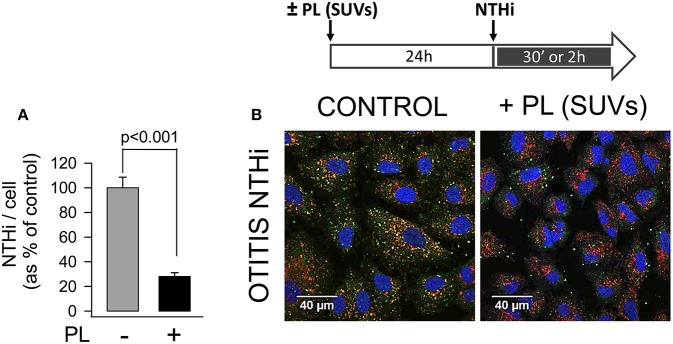
Endocytosis of surfactant lipids attenuates NTHi entry in pneumocytes. MLE-12 cells were incubated with or without SUVs composed of surfactant lipids (250 μg PL/ml) for 24 h. Then cells were infected with otitis NTHi, and bacterial invasion assays were performed. Cells were then washed, fixed, and permeabilized with 0.1% saponin. For confocal microscopy analysis, internalized bacteria were stained with an anti-NTHi antibody and Alexa Fluor 488-conjugated secondary antibody. Late endosomes were stained with anti-LAMP1 antibody conjugated with phycoerytrin, and nuclei were stained with DAPI. (A) The graph shows the percentage of internalized bacteria relative to cell associated individual bacteria. Mean ± SEM of two independent experiments are shown. Student's t-test was used. (B) Representative micrographs are shown.